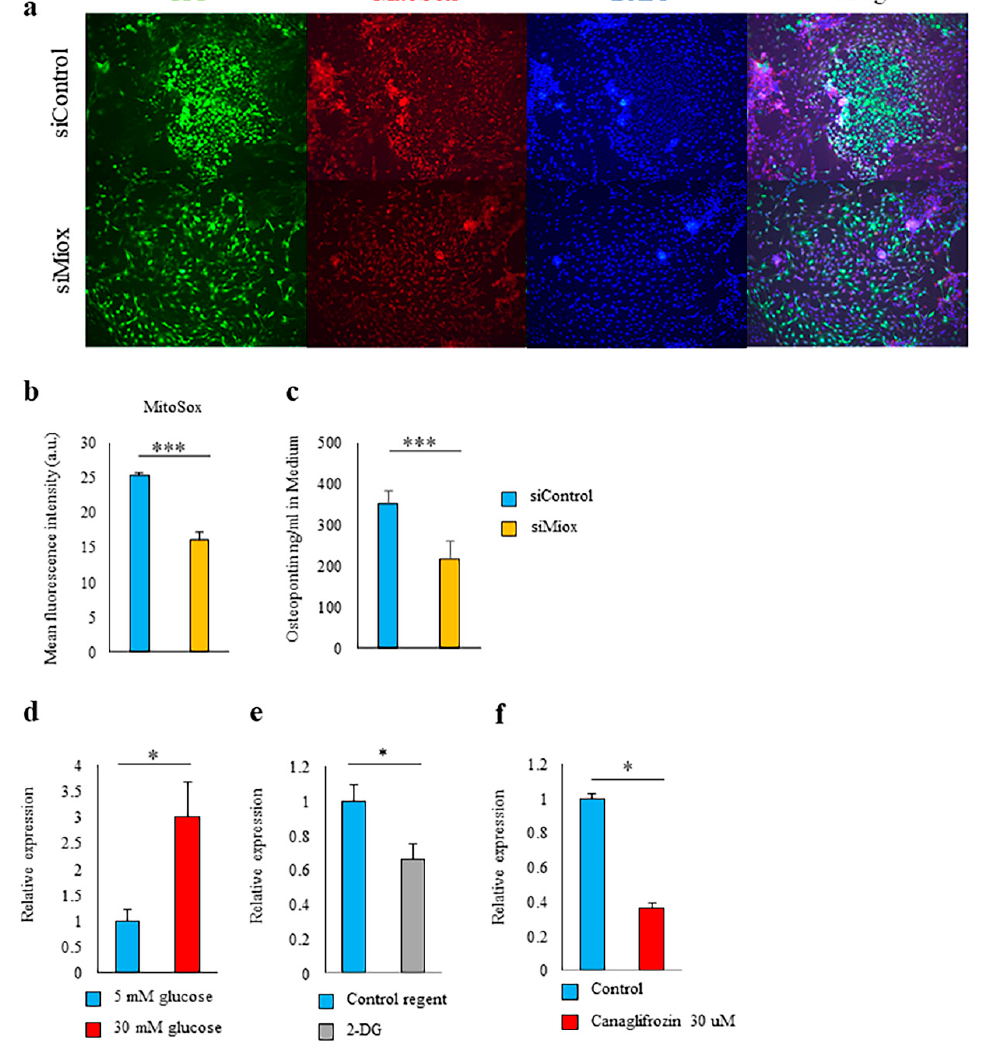
Figure 5. Upregulation of myo-inositol oxygenase (MIOX) regulated the Spp1 transcriptional activity in the proximal renal tubular cells. ( a – c ) Proximal tubular epithelial cells (PTEC) were cultured for 7 days with small interfering (si)Control or siMIOX. ( a ) Microscopic analysis of fluorescence of 4 (cid:48) ,6-diamidino-2-phenylindole (DAPI) and MitoSOX staining and of EGFP- Spp1 expression. ( b ) Mean fluorescence intensity of MitoSox in PTEC ( n = 4–6 per group). ( c ) Osteopontin (OPN) in the culture supernatants was assessed by enzyme-linked immunosorbent assay ( n = 6 per group). ( d – f ) The mRNA expression levels of MIOX were quantified in PTEC cultured in the indicated conditions. * p < 0.05, *** p < 0.001. Data are shown as means, and error bars depict